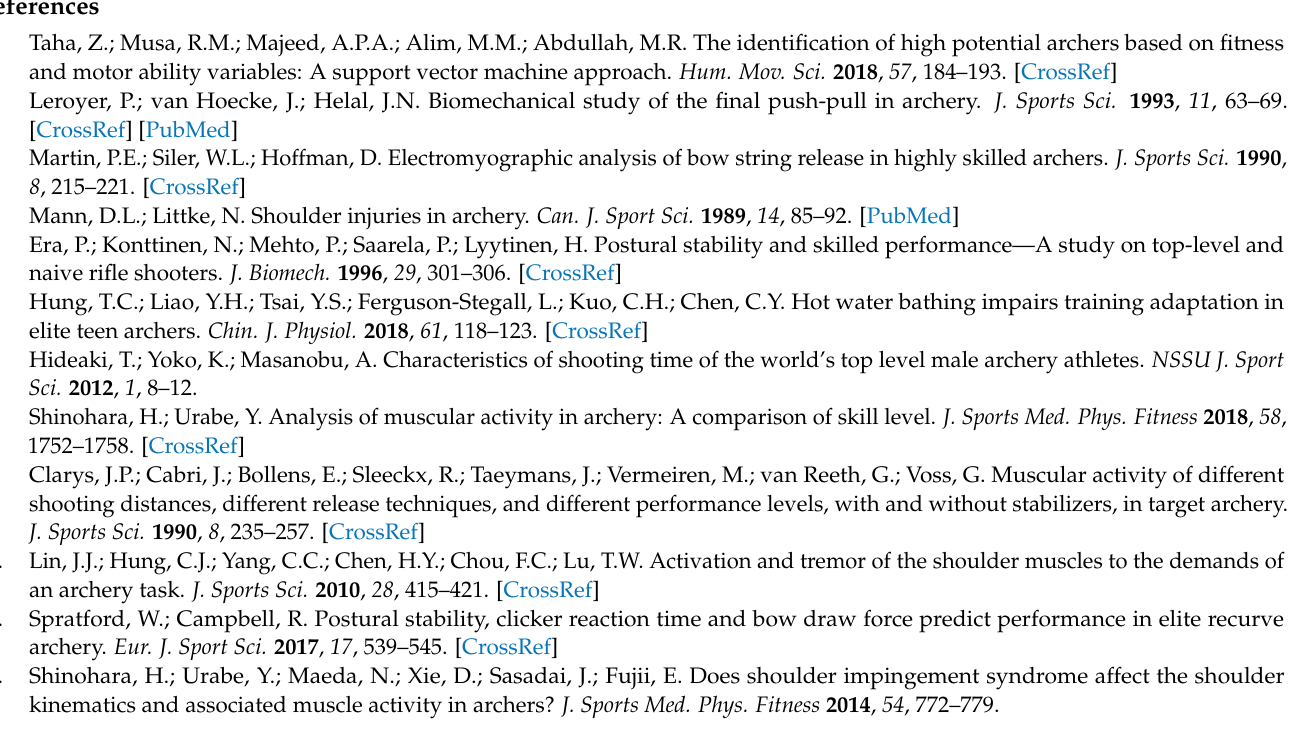
Figure S1: Shoulder angle of drawing